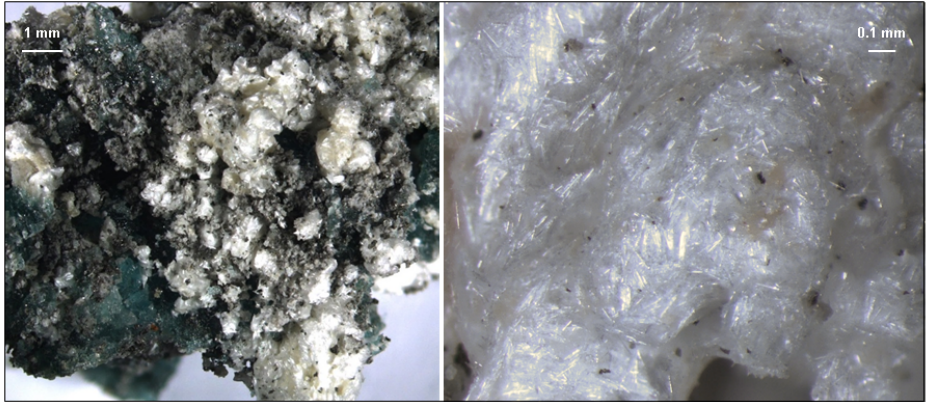
Figure 2. Stereomicroscope images of halotrichite (sample 20-white).